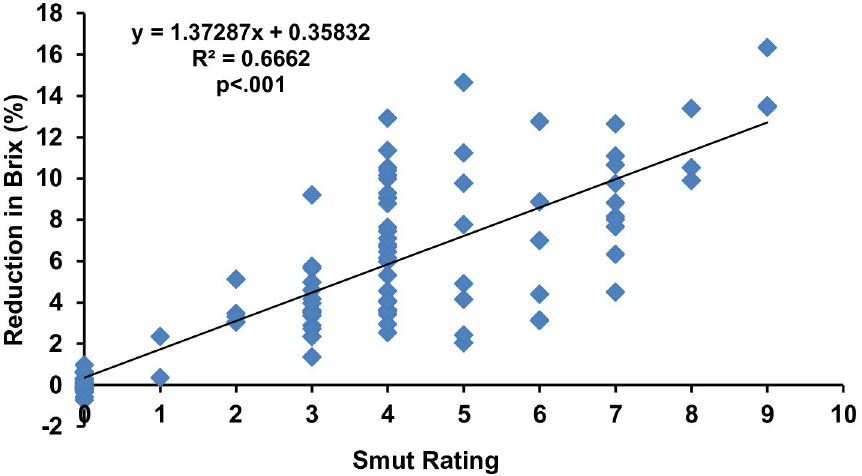
Fig 1. Regression analysis of brix percentage with whip smut disease rating. Note: The smut rating is not a linear scale. It’s based on the transformation explained in methods from linear incidence value to the rating. Accordingly, the resulting disease incidences were converted into 0–9 disease rating scale [41], where 0: no disease, 1: 0.1–2.5%, 2: 2.6– 5.5%, 3: 5.6–7.5%, 4: 7.6–12.5%, 5: 12.6–15.5%, 6: 15.6–18.0%, 7: 18.1–22.5%, 8: 22.6–25.5% and 9: 25.6–100%.